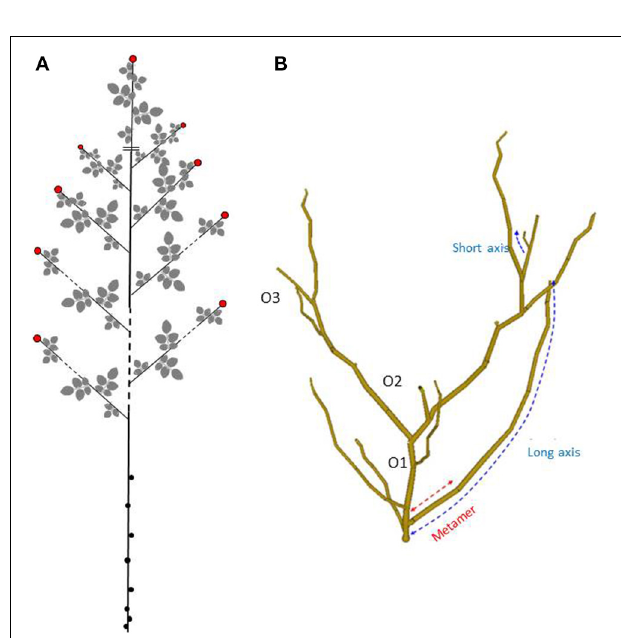
FIGURE 4 | (A) Representation of a n-1 year old axis carrying n year old floriferous axes (terminal flower in red) in a non-recurrent flowering rose; (B) Representation obtained by digitizing of an elementary architectural structure of a rose having an upright growth habit, aged from 5 to 6 months, cultivated in greenhouse. Three architectural components (metamer, short, and long axes) and three branching orders are labeled (O1, O2, and O3) (From Crespel et al.,